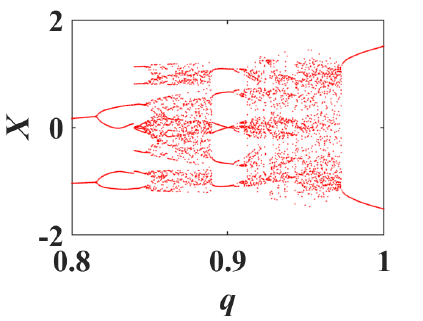
Figure 6. Bifurcation diagrams with k = 1.9, q ∈ ( 0.8,1 )